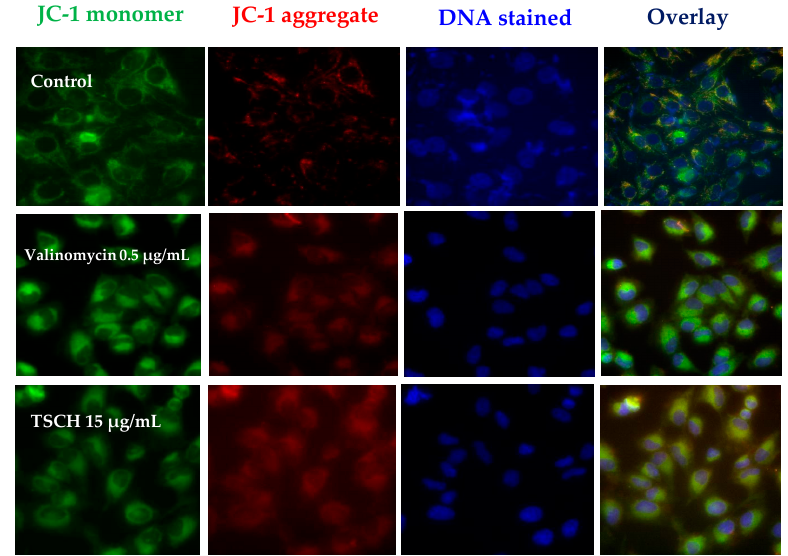
Figure 1. Fluorescence image of HeLa cells labeled with JC-1 and DNA stain Hoechst 3342 (blue). Cells were treated with valinomycin (0.5 µg/mL) and water extract of tamarind seed coat (TSCH) at concentrations of 5 and 15 µg/mL. Left and middle left panels show aggregate (red) and monomer (green) fluorescence, respectively. The right panels show the overlay of the two images; in this case, the orange/yellow color denotes co-localization of the red and green fluorescence signals.